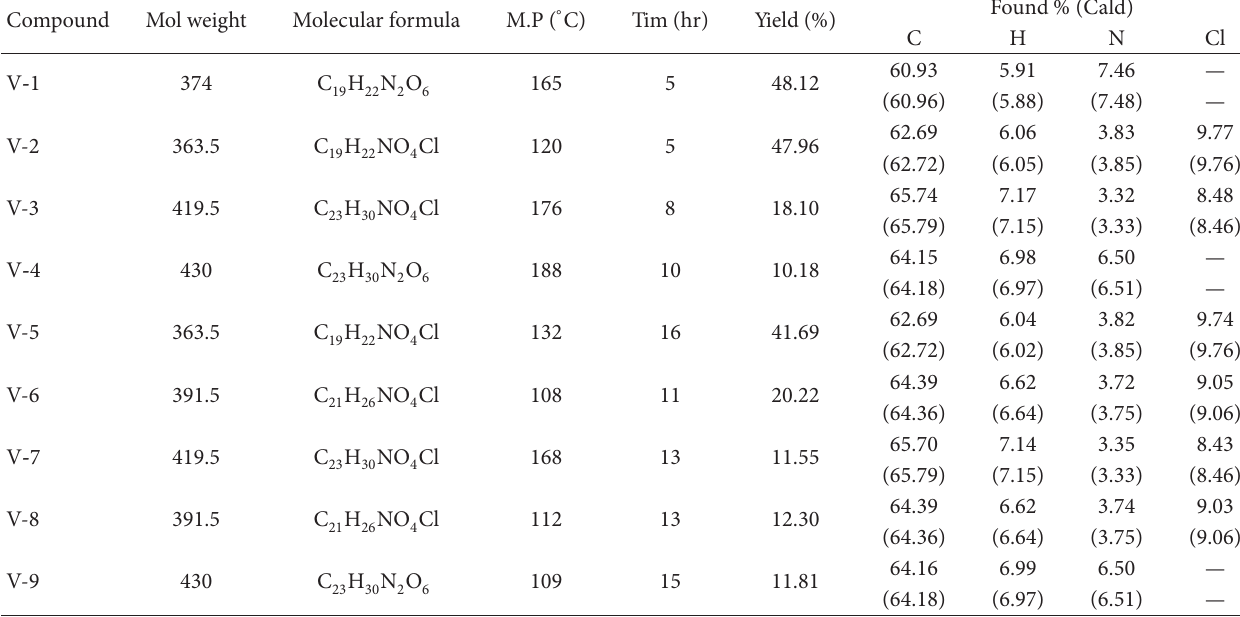
T 1: Analytical data of compounds V-1 to V-9.